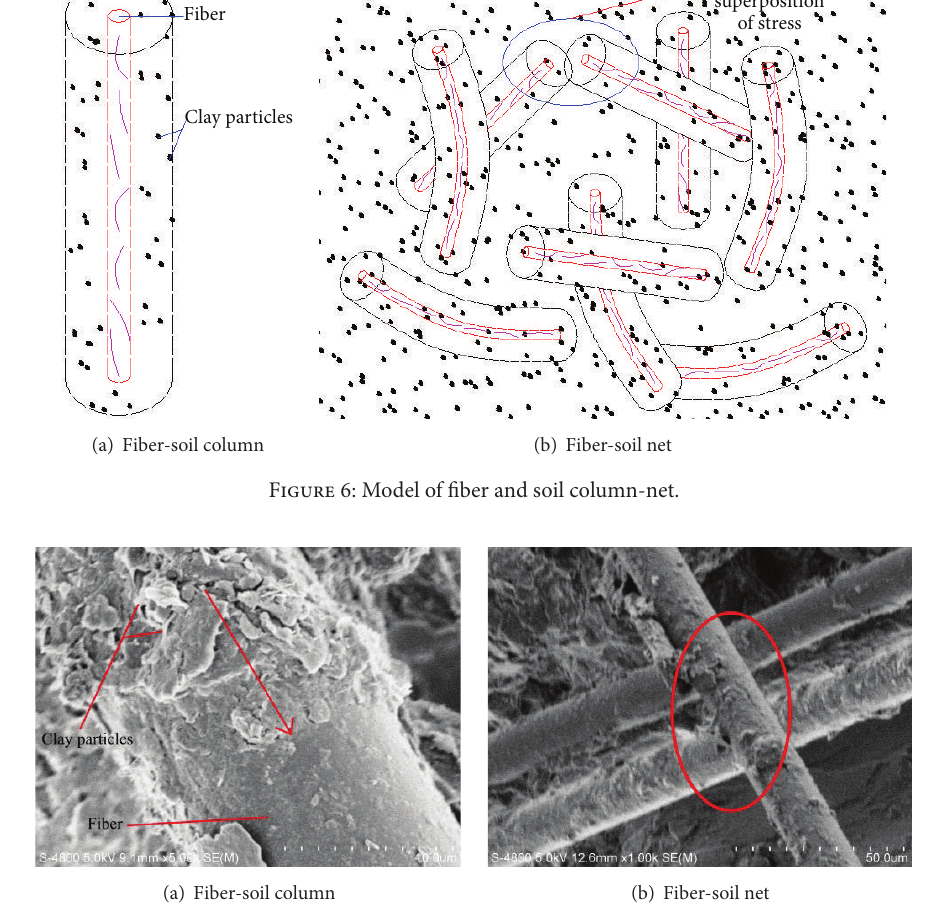
Figure 7: SEM micrograph of fiber-soil